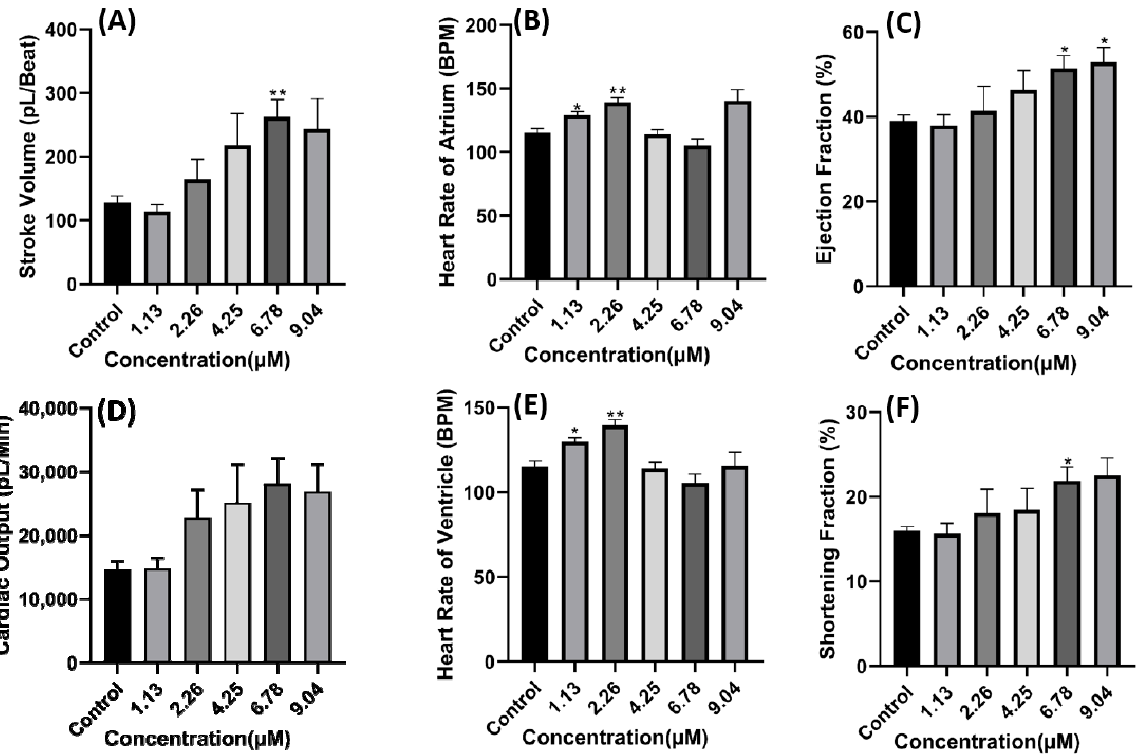
Figure 5. Cardiac physiology alteration induced by carbofuran in zebrafish larvae. ( A ) Stroke volume. ( B ) Heart rate of atrium. ( C ) Ejection fraction. ( D ) Cardiac output. ( E ) Heart rate of ventricle. ( F ) Shortening fraction. Data were statistically analyzed using ordinary one-way ANOVA with a Dunnett post-hoc test for multiple comparisons. * p < 0.05, * * p < 0.005.